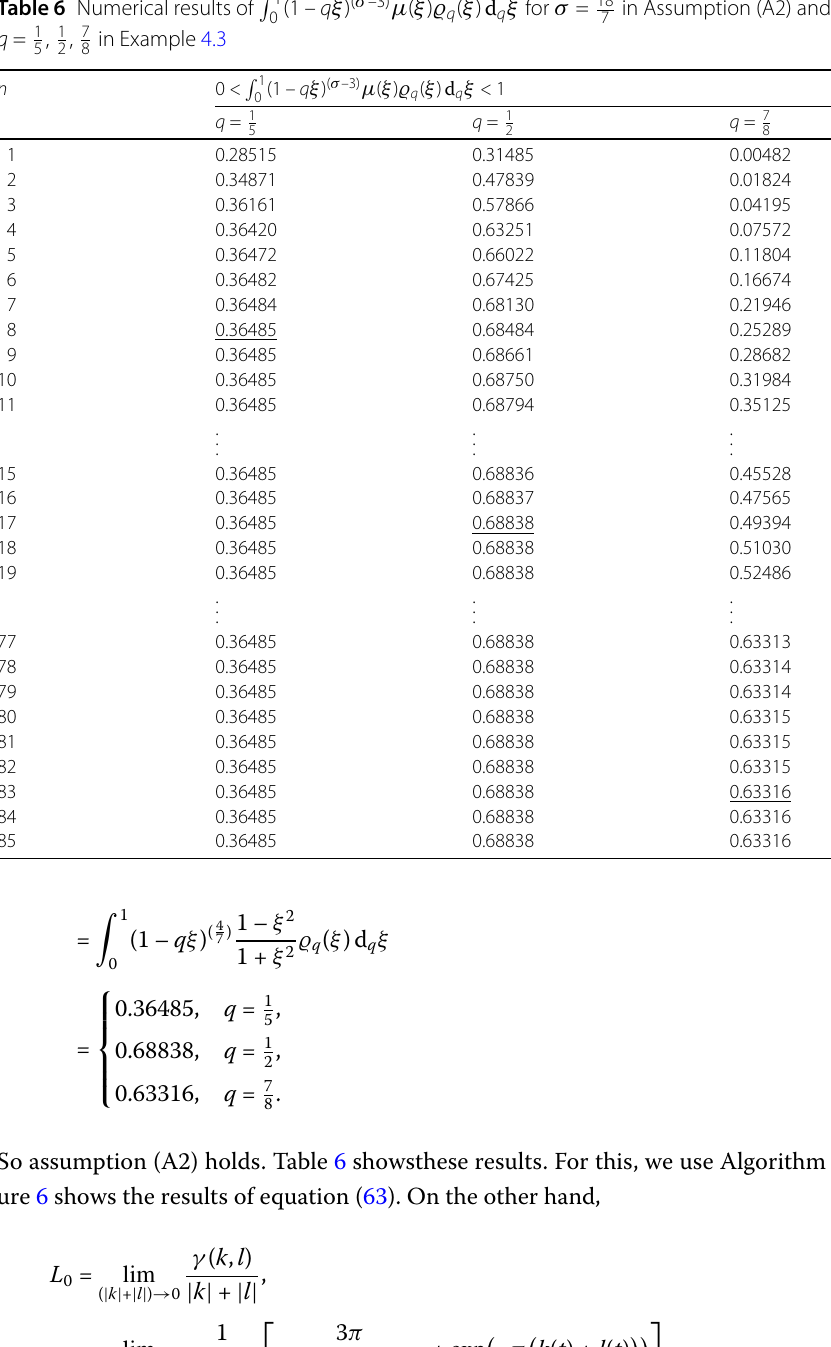
(cid:5) 1 (1 – q ξ ) ( σ –3) μ ( ξ ) (cid:18) q ( ξ ) d q ξ for σ = 18 0